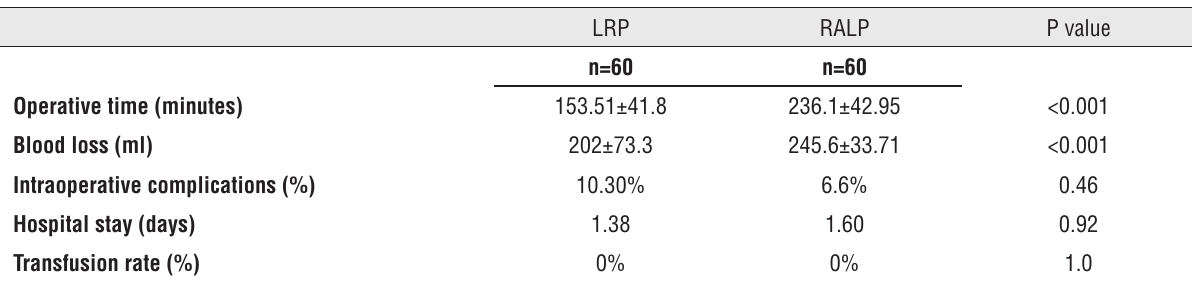
Table 2 - Perioperative outcomes. Robotic-assisted radical prostatectomy presented longer operative time and higher blood loss when compared to lRP.